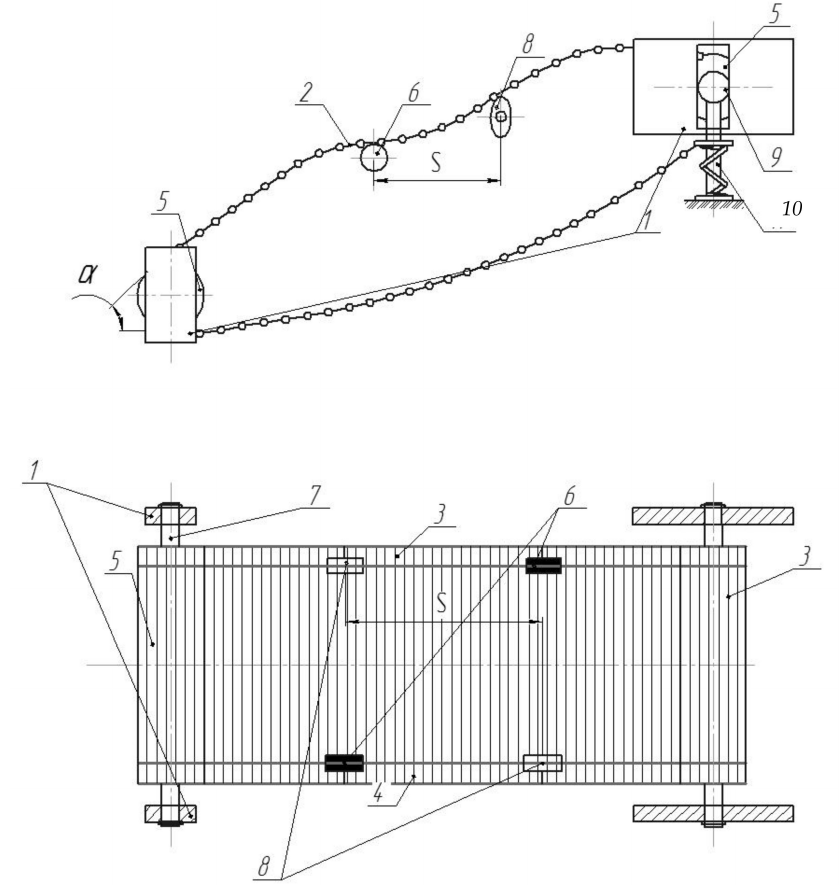
Figure 6. Diagram of a separating rod elevator: 1, frame; 2, rod elevator; 3–4, branches of a rod elevator; 5, leading roller; 6, supporting roller; 7, driven roller; 8, elliptical shaker; 9, a shaft of a conducted roller; 10, a mechanism for regulating vertical